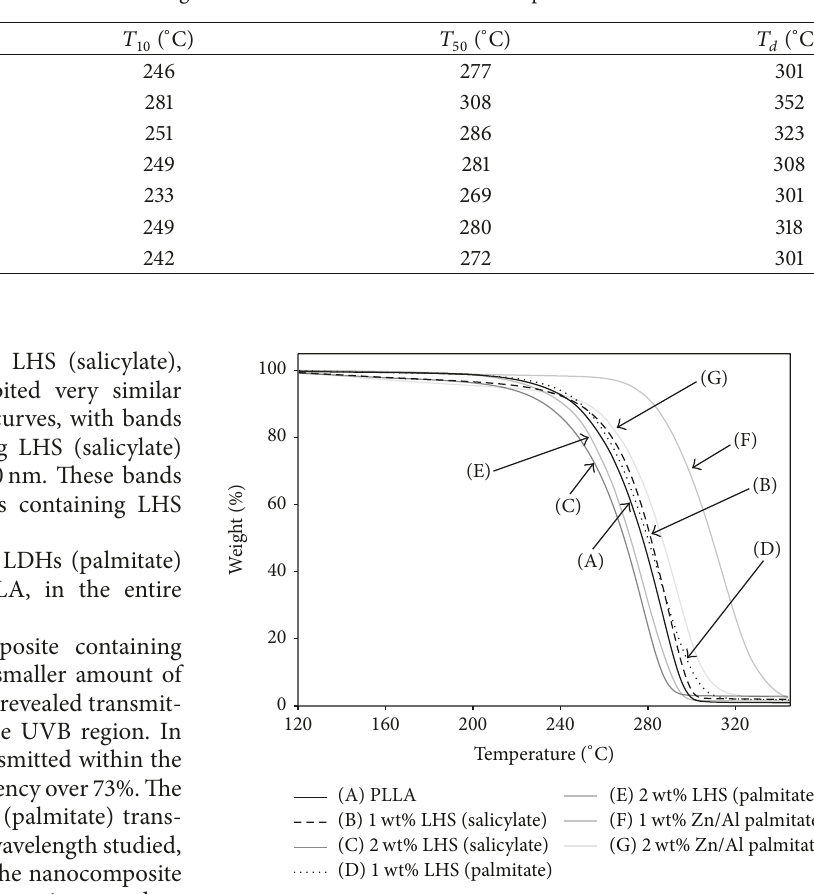
Table 1: Temperatures for the thermal degradation of PLLA and PLLA nanocomposites.